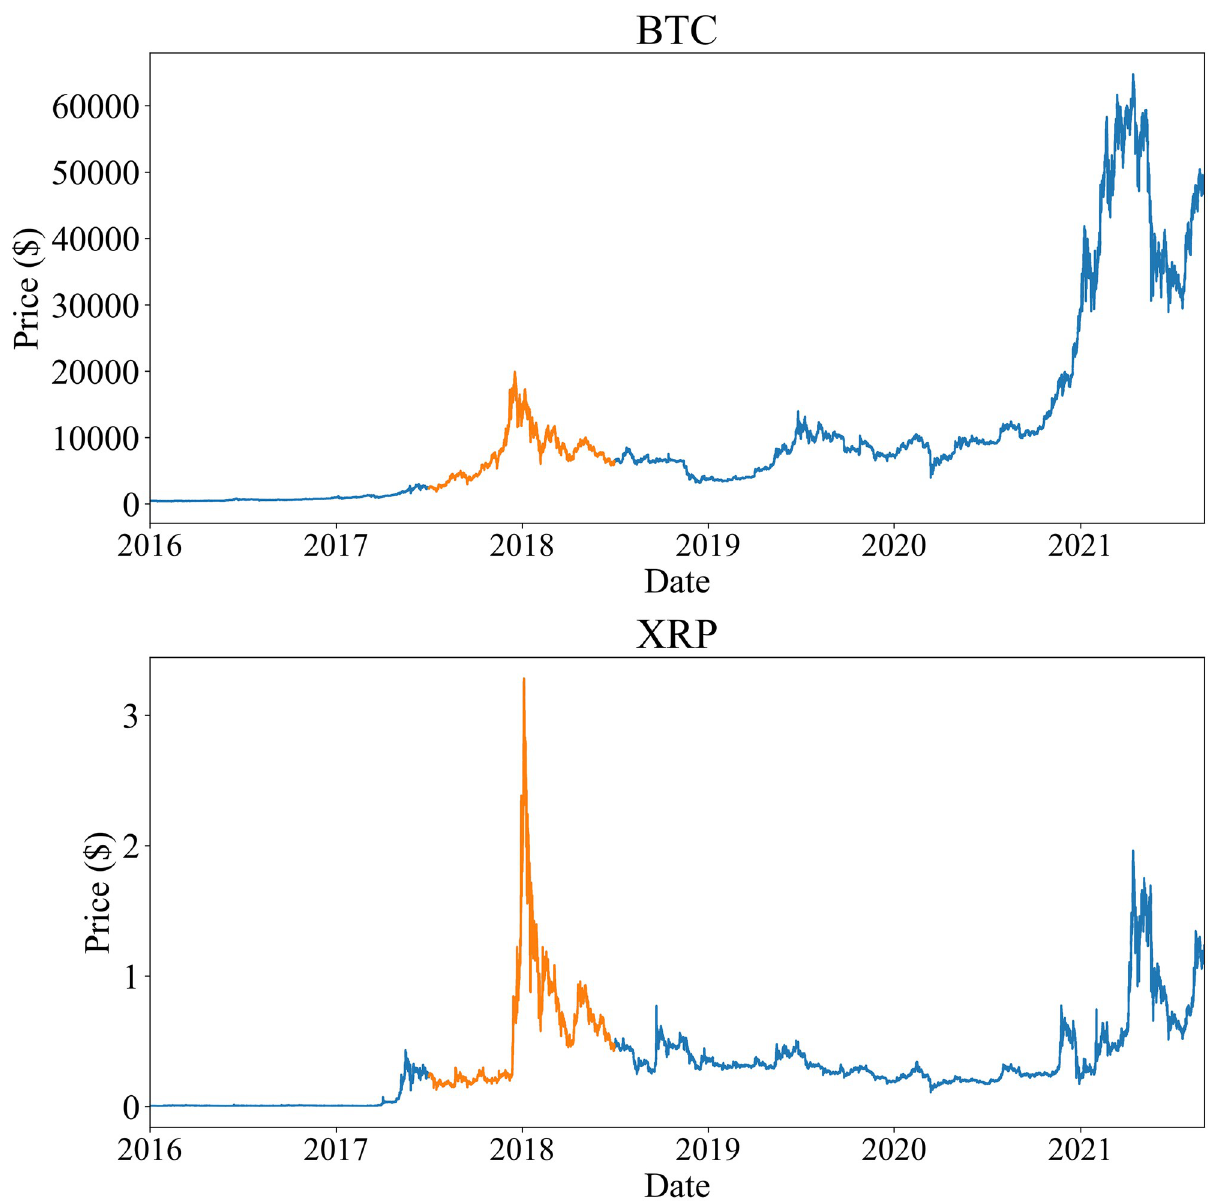
Fig 1. Price chart for Bitcoin (top) and XRP (bottom). Orange lines represent the price for the period from July 2 2017 to June 30 2018. The peaks are located at December 17 2017 for Bitcoin and January 4 2018 for XRP.